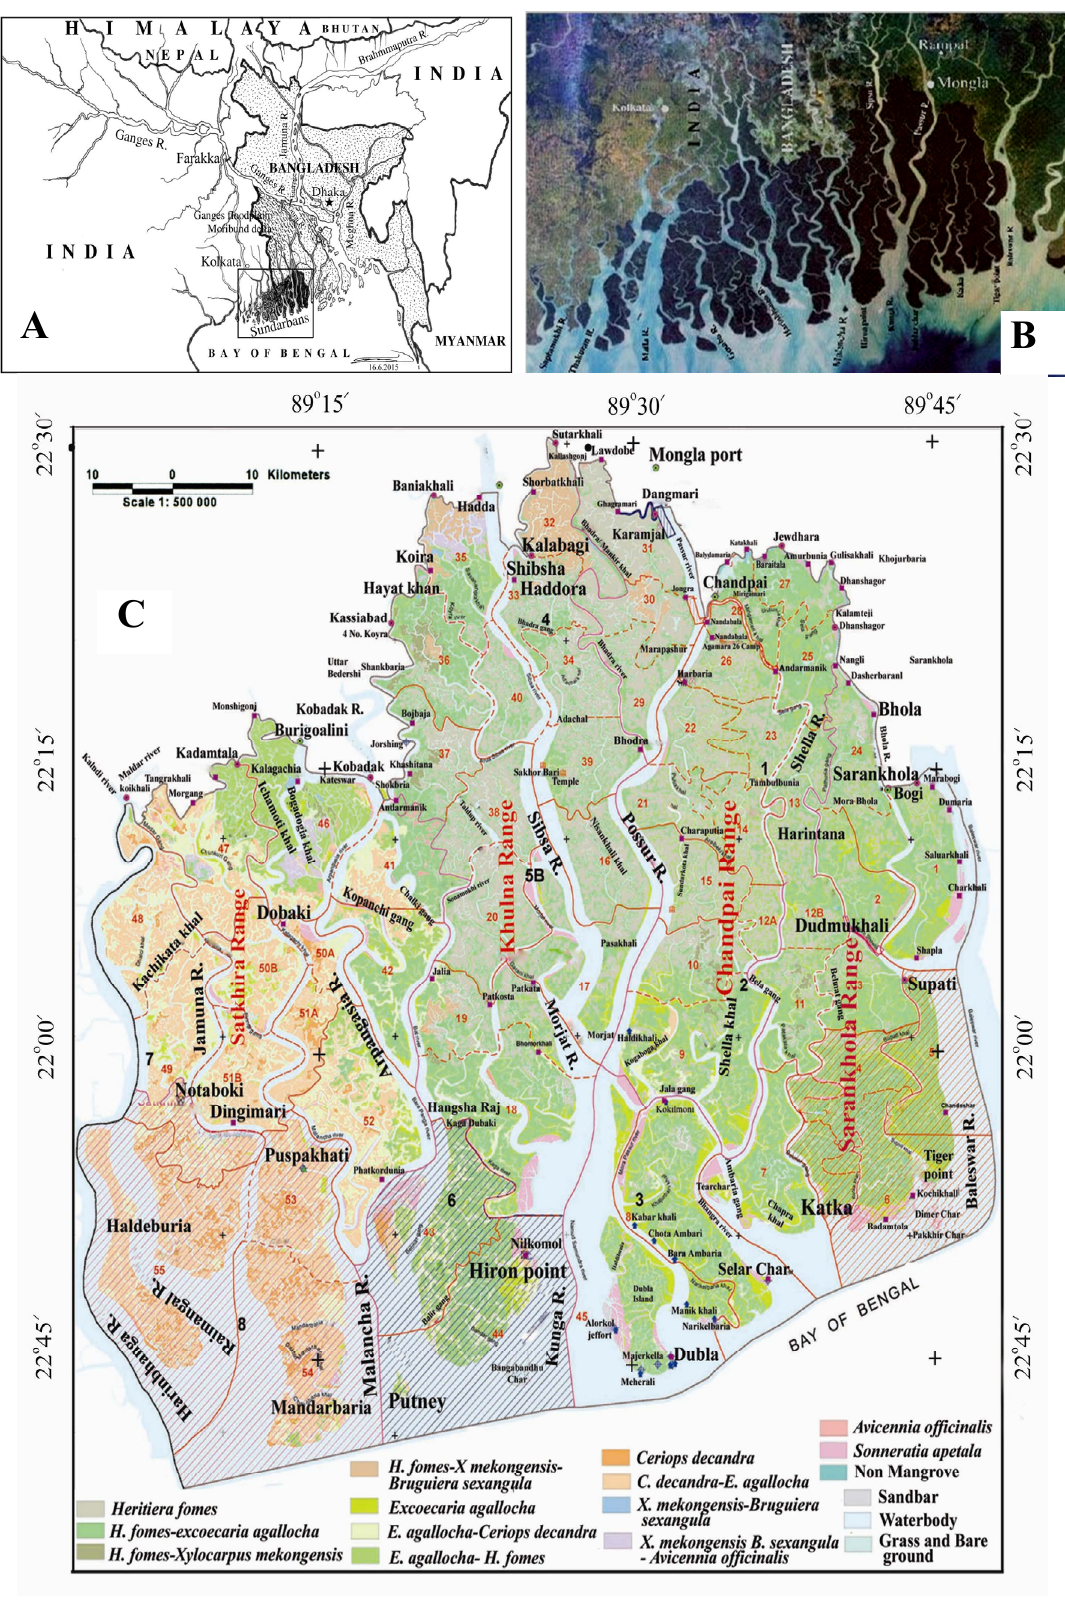
Figure 1. ( A ) Map of Bangladesh and parts of adjacent countries showing the origins of three mighty rivers; ( B ) The satellite image of total Sundarbans showing the network of rivers; the dark areas in the north and northeast are dominated by trees >15 m high; ( C ) The Bangladesh